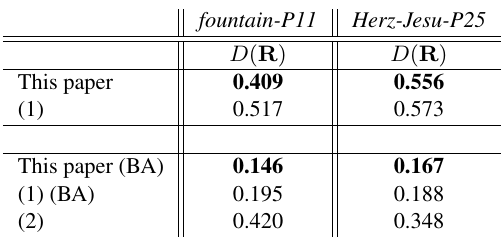
Table 1: Results of the rotation estimation using different weight- ings. Mean distance to ground truth (upper part) and standard deviation (lower part), both in [ ◦ ] .